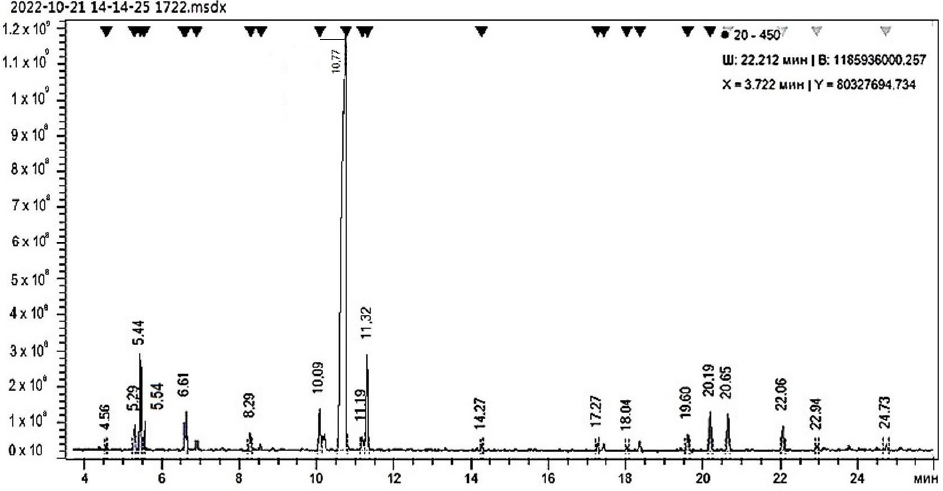
Figure 1. Chromatogram of the component composition of the promising accession, 2022.